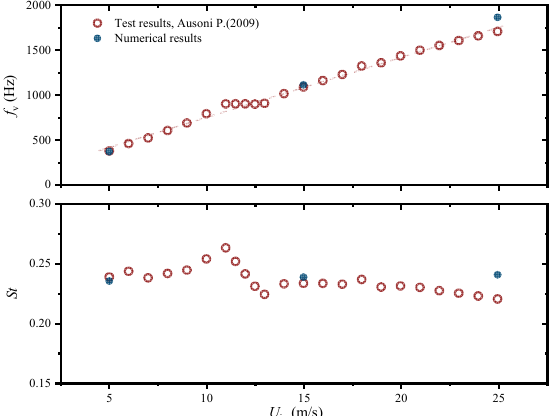
Figure 5. Comparison of numerical results and experimental data.